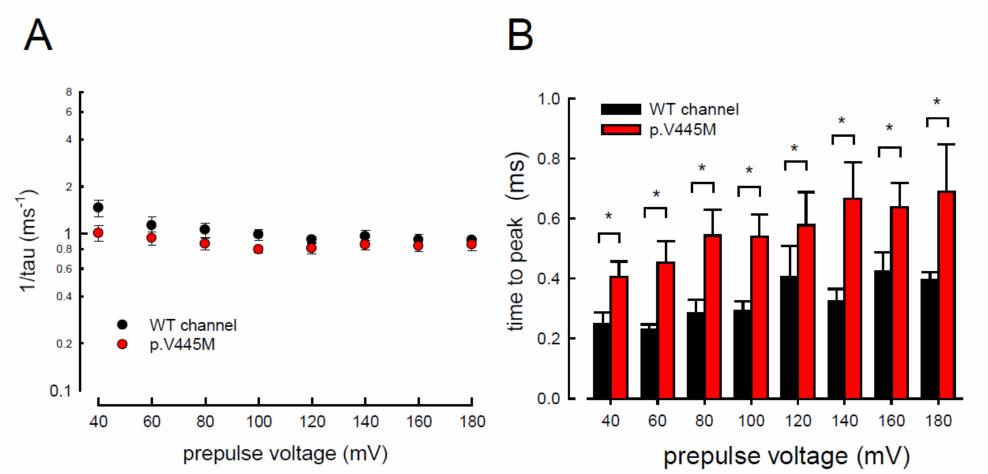
Figure 6. Accelerated decay of resurgent Na + currents by hyperpolarization between the WT and p.V445M mutant channels in the CHO-K1 cells ( A ) The inverses of decay time constants (1 / tau) of the resurgent Na + currents are obtained at − 60 mV after the depolarizing prepulses between + 40 and + 180 mV in 20 mV increments for ~10 ms in the WT and p.V445M mutant channels ( n = 8). ( B ) The time to peak of resurgent Na + currents in the WT channel is always faster than that in the p.V445M mutant channel at the prepulse voltages tested ( n = 8 *; p < 0.05).